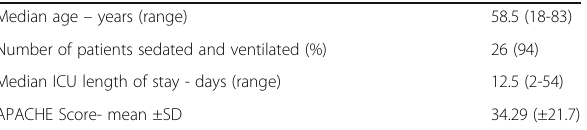
Table 1 (abstract 000057). Patient Characteristics